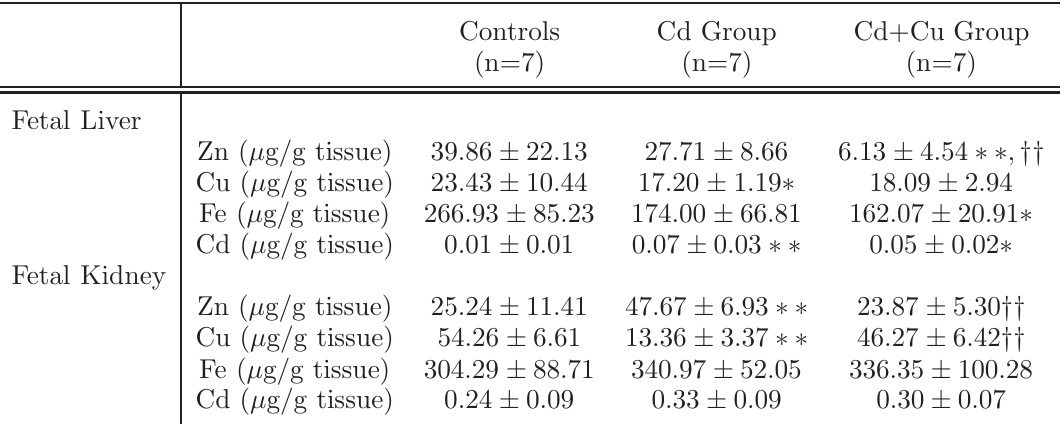
Table 3 Comparisons between element levels in fetal livers and kidneys (mean ± SD).